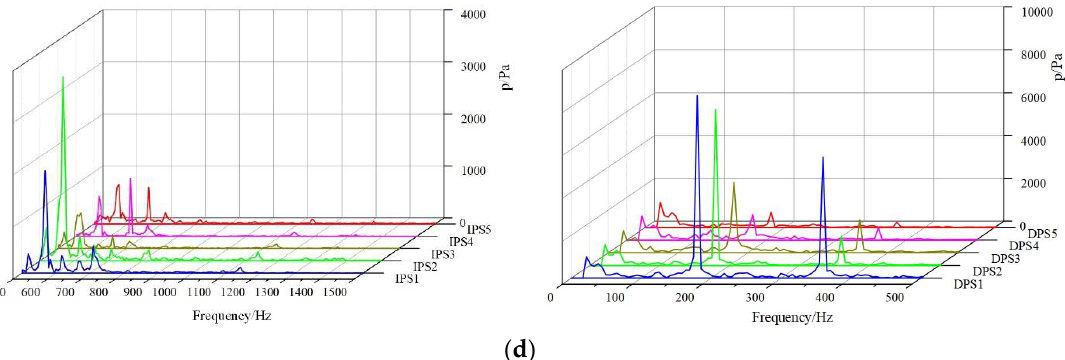
Figure 6. Frequency spectra of pressure fluctuations on IPS1-IPS5 and DPS1-DPS5. ( a ) GVF = 0%; ( b ) GVF = 5%; ( c ) GVF = 10%; ( d ) GVF = 15%.